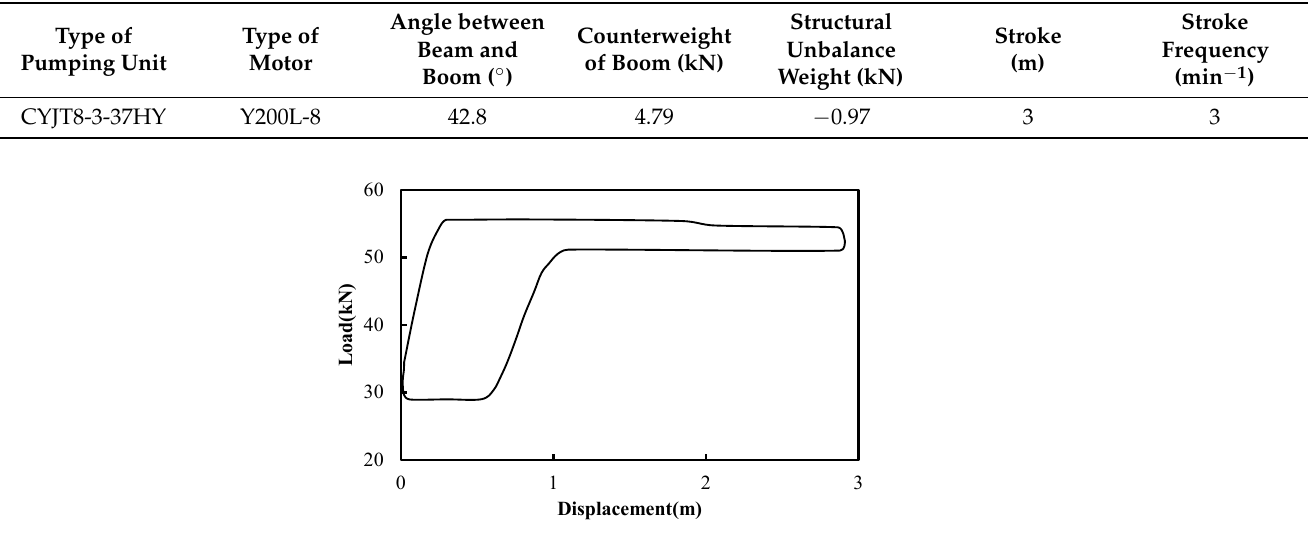
Figure 5. Measured dynamometer card.